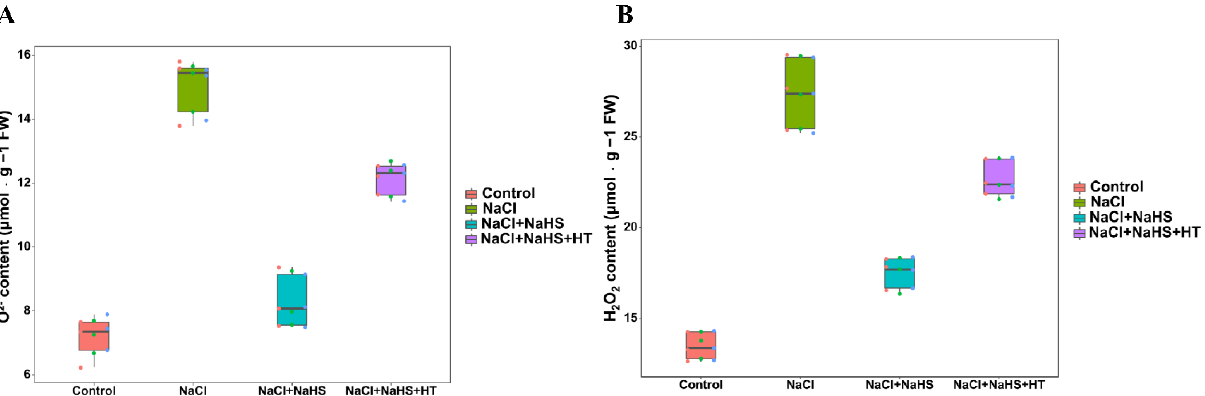
Figure 6. Effect of NaHS application on O 2 − content ( A ) and H 2 O 2 content ( B ) of explants species. The primary roots were removed from hypocotyl of 5-day-old seedlings. Explants were incubated for 5 days with distilled water (the control), NaCl, NaCl + NaHS, NaCl + NaHS + HT. Values are means of three independent replicates.